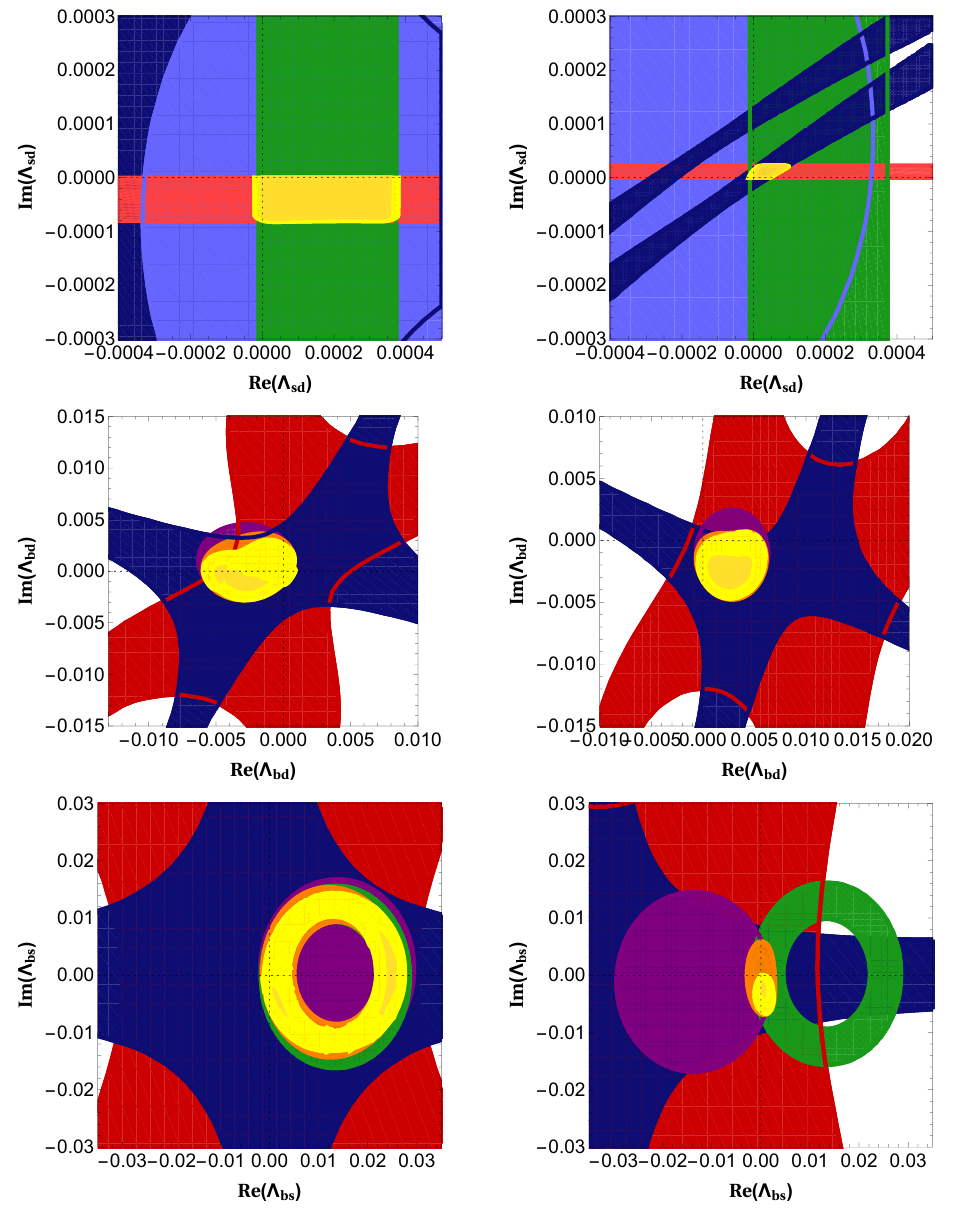
Figure 6. Fits of Im((cid:3) ij ) vs. Re((cid:3) ij ) for ij = sd; bd; sd [upper, middle, lower] in G SM -scenarios D [left] and Q V [right] for M VLQ = 1 TeV. The colour scheme is as in (cid:12)gure